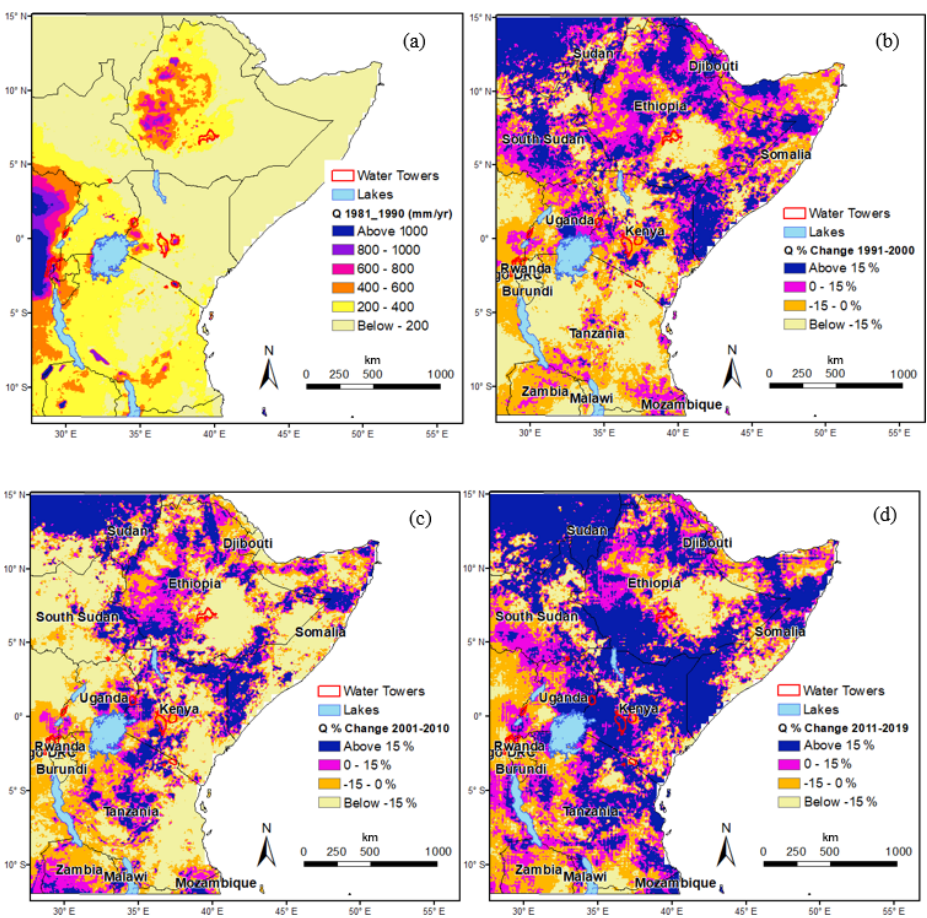
Figure 6. Spatial distribution of simulated water yield. (a) Q is for 1981–1990, (b) Q is for changes in 1991–2000, (c) Q is for changes in 2001–2010, and (d) Q is for changes in